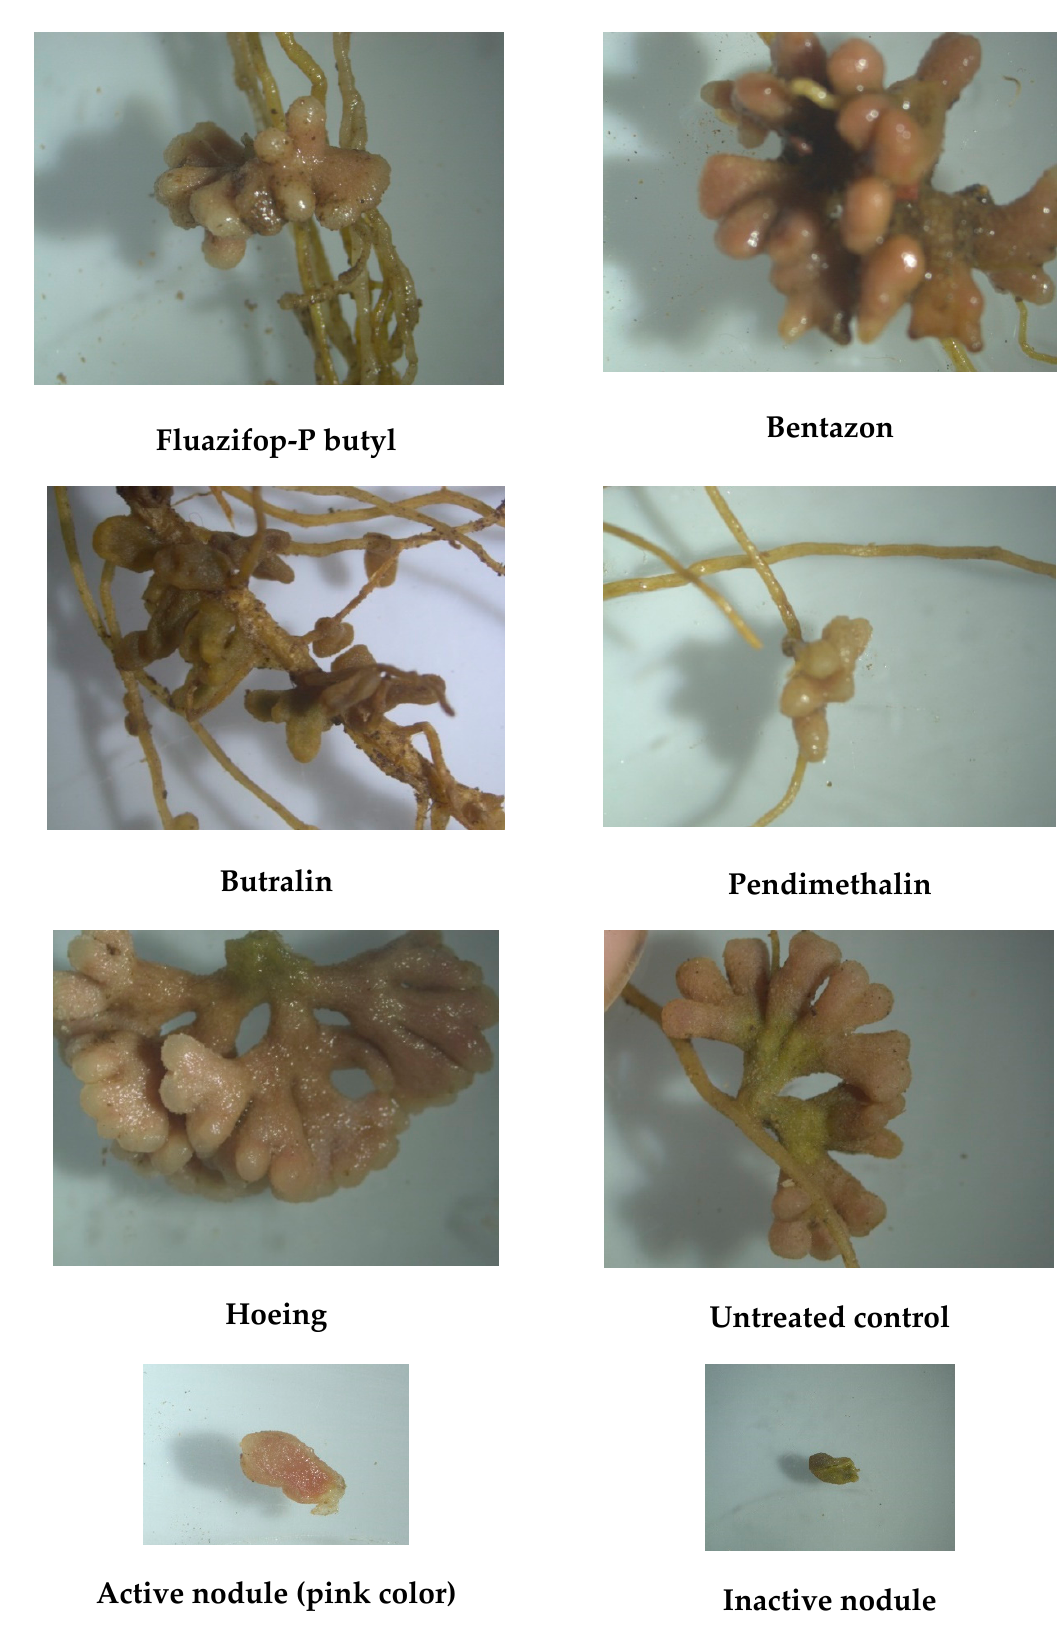
Figure 2. Effect of pre- and postemergence herbicides on nodule formation.